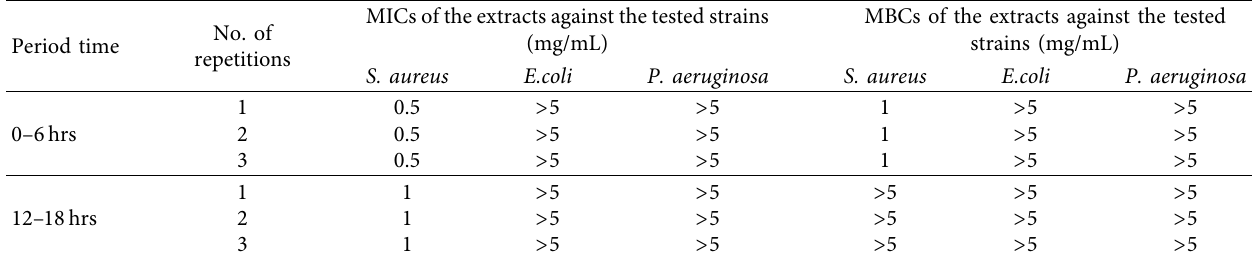
Table 6: Te minimum inhibitory concentration (MIC) and minimum bactericidal concentration (MBC) of essential oils from immature leaves of B. balsamifera extracted by hydrodistillation at the period of 0–6 hrs and 12–18hrs against in vitro growth of S. aureus, E. coli, and P. aeruginosa .